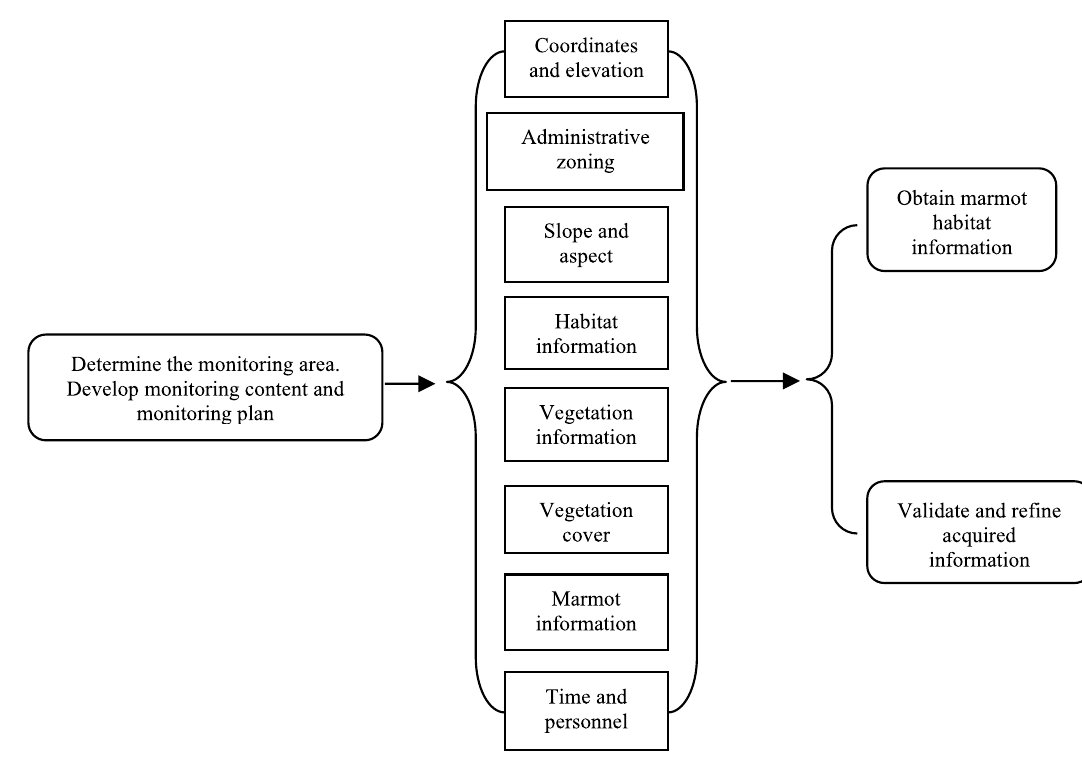
Figure 1. Workflow of Himalayan marmot